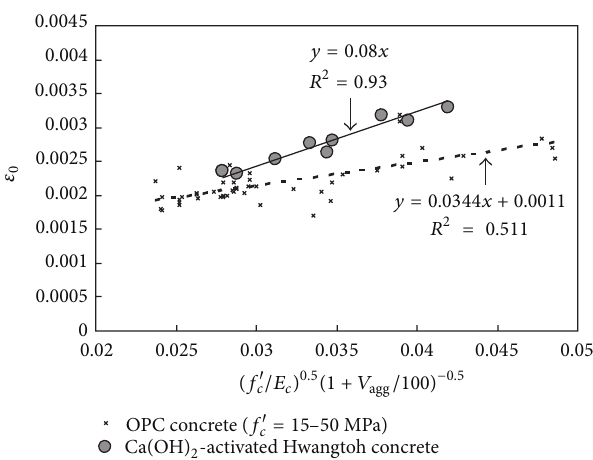
Figure 7: Regression analysis for strain ( 𝜀 0 ) at peak stress.